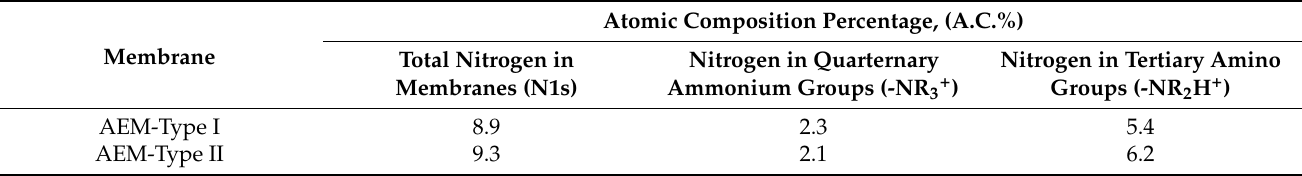
Table 1. The atomic compositions of nitrogen in two anion exchange membrane surfaces from XPS analysis.